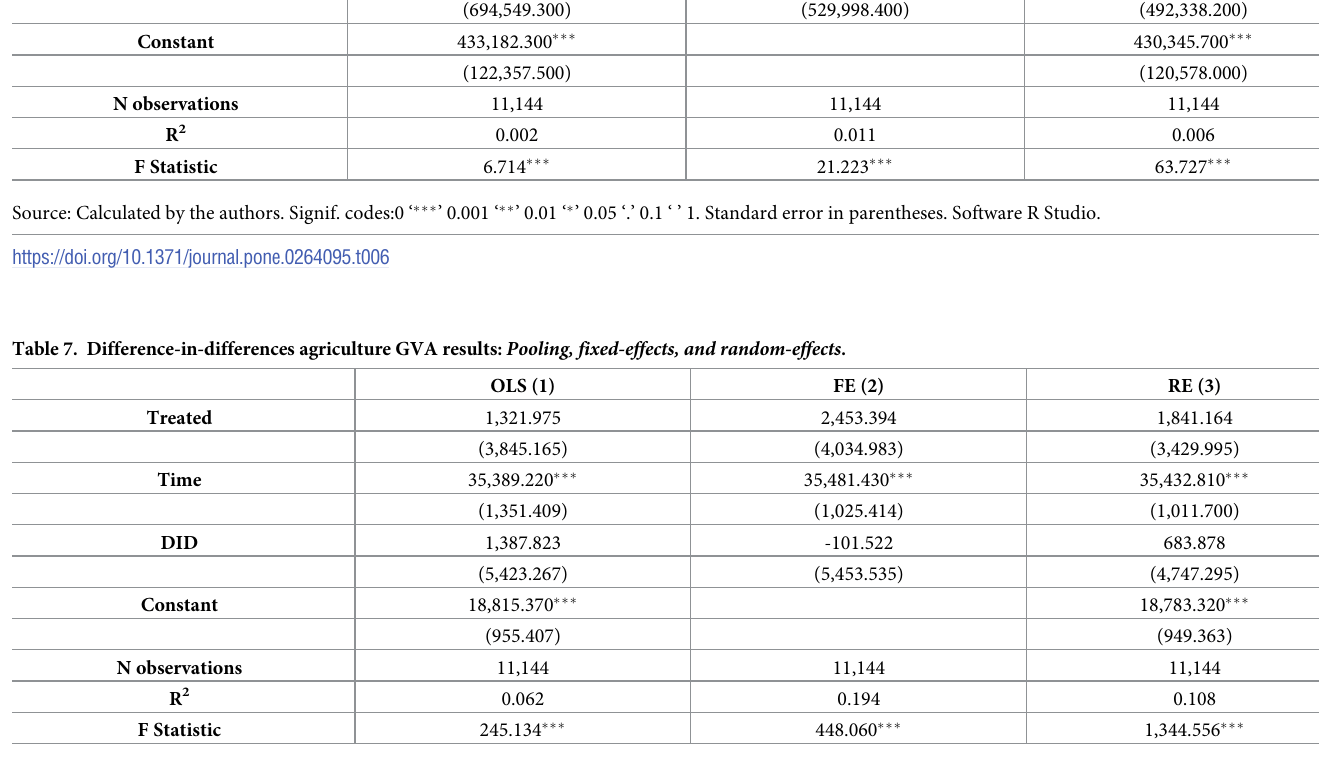
Table 6. Difference-in-differences GDP results: Pooling, fixed-effects, and random-effects . OLS (1) FE (2) RE (3) Treated